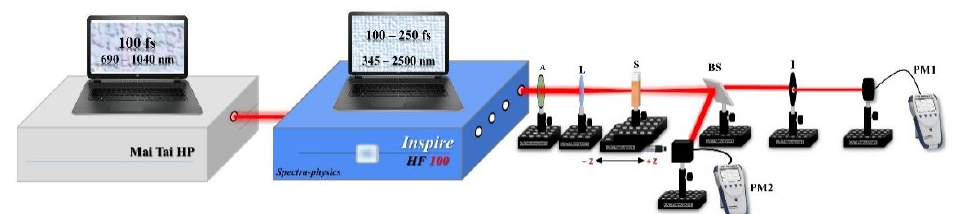
Figure 2. The experimental setup of the z-scans: A, attenuator; L, convex lens; S, Au NP sample; BS, beam splitter; I, iris; PM, power meter.